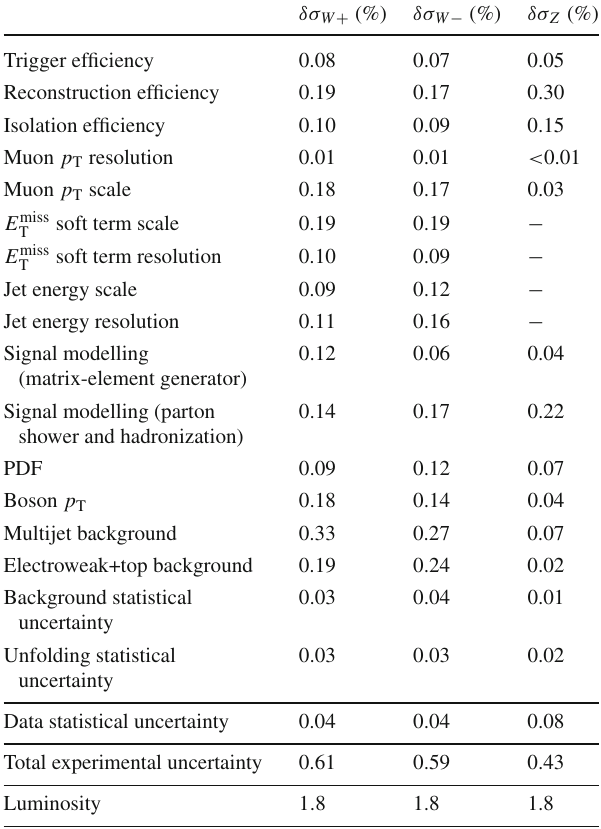
Table 6 Relative uncertainties δσ in the measured integrated fiducial cross sections times branching ratios in the muon channels. The effi- ciency uncertainties are partially correlated between the trigger, recon- struction and isolation terms. This is taken into account in the compu- tation of the total uncertainty quoted in the table δσ W + (%)